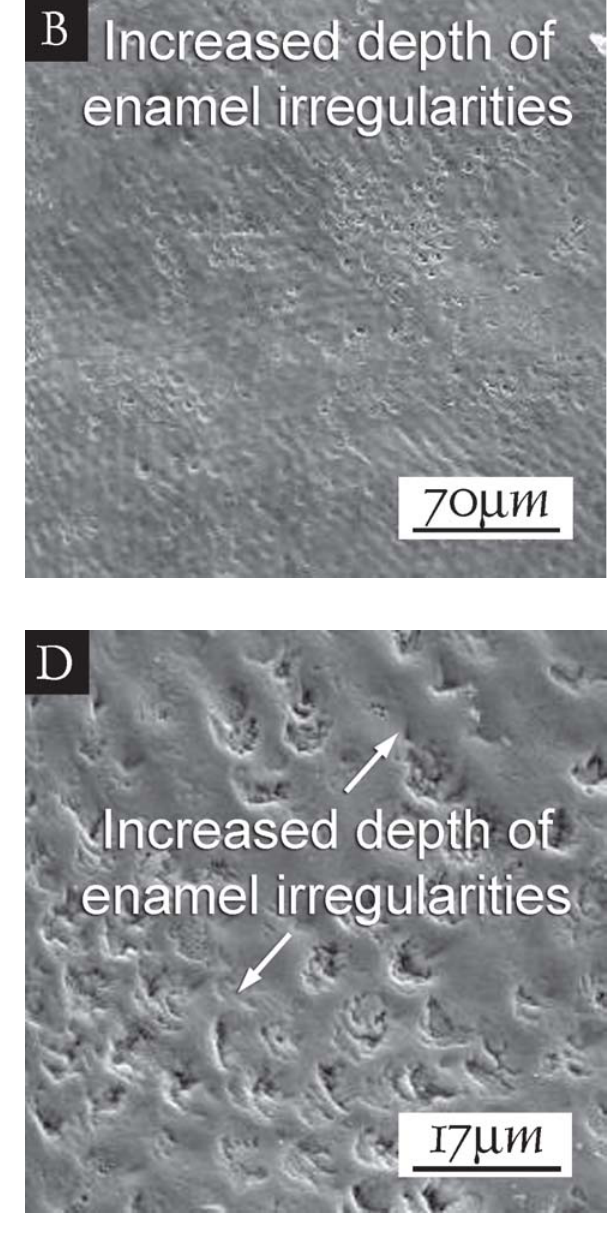
FIGURE 4- Photomicrographs of bleached enamel after 35% hydrogen peroxide applications at 500x (A and B) and 2000x magnifications (C and D): depressions, removal of the aprismatic layer, and increased depth of enamel